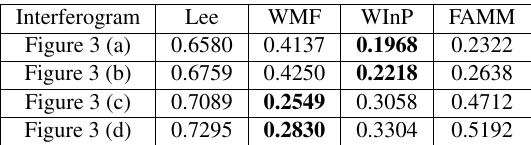
Table 2: Normalized Mean Square Error (NMSE)